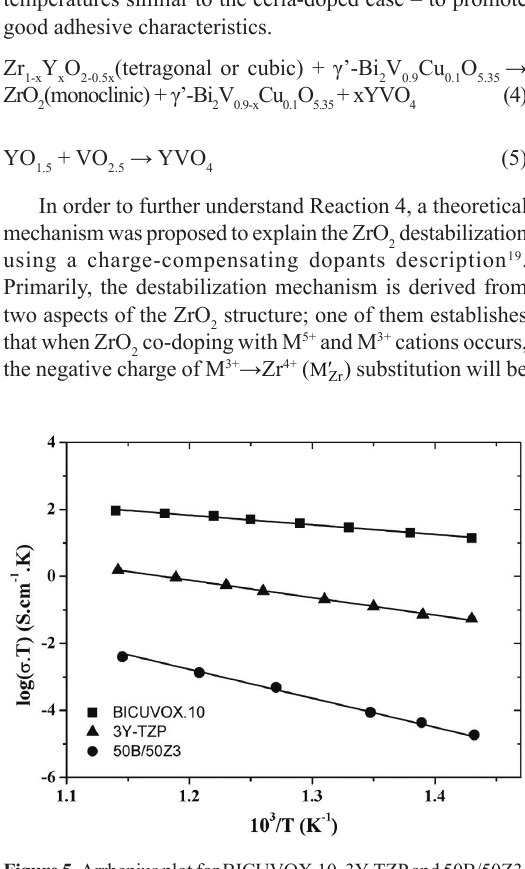
polymorphs destabilization and YVO nucleation. This charge-compensating 2 4 2